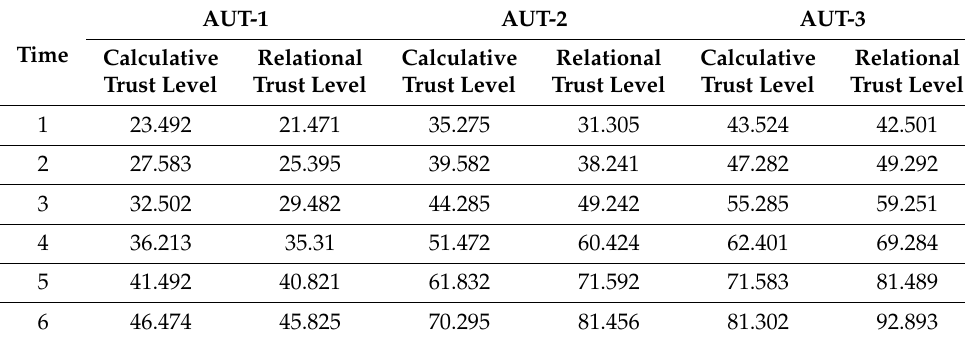
Table 4. Scenario C simulation